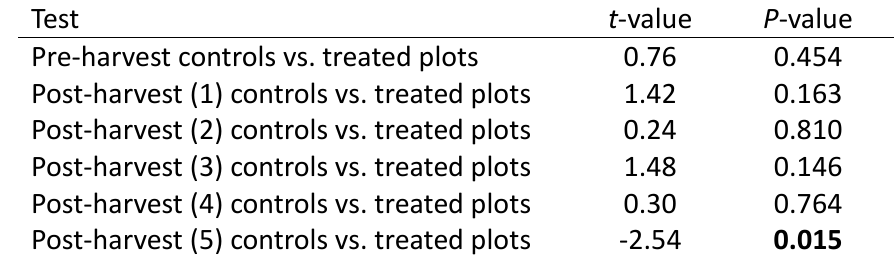
Table A1.4 . Year-specific treatment effects on density of Swainson’s Thrush, according to multiple comparison analyses (DF =